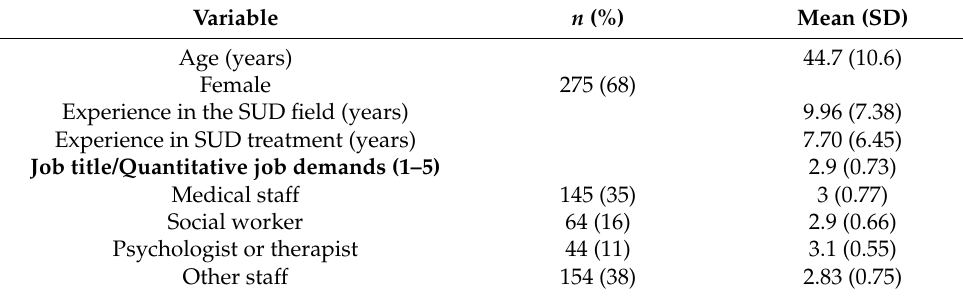
Table 1. Participants’ personal and professional characteristics ( n =